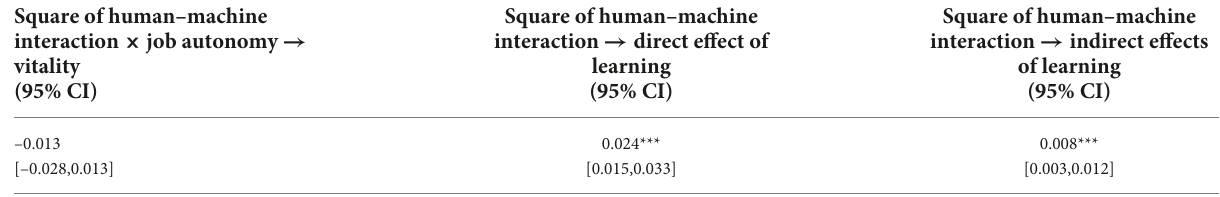
TABLE 9 Tests for mediating effects of job autonomy regulation.